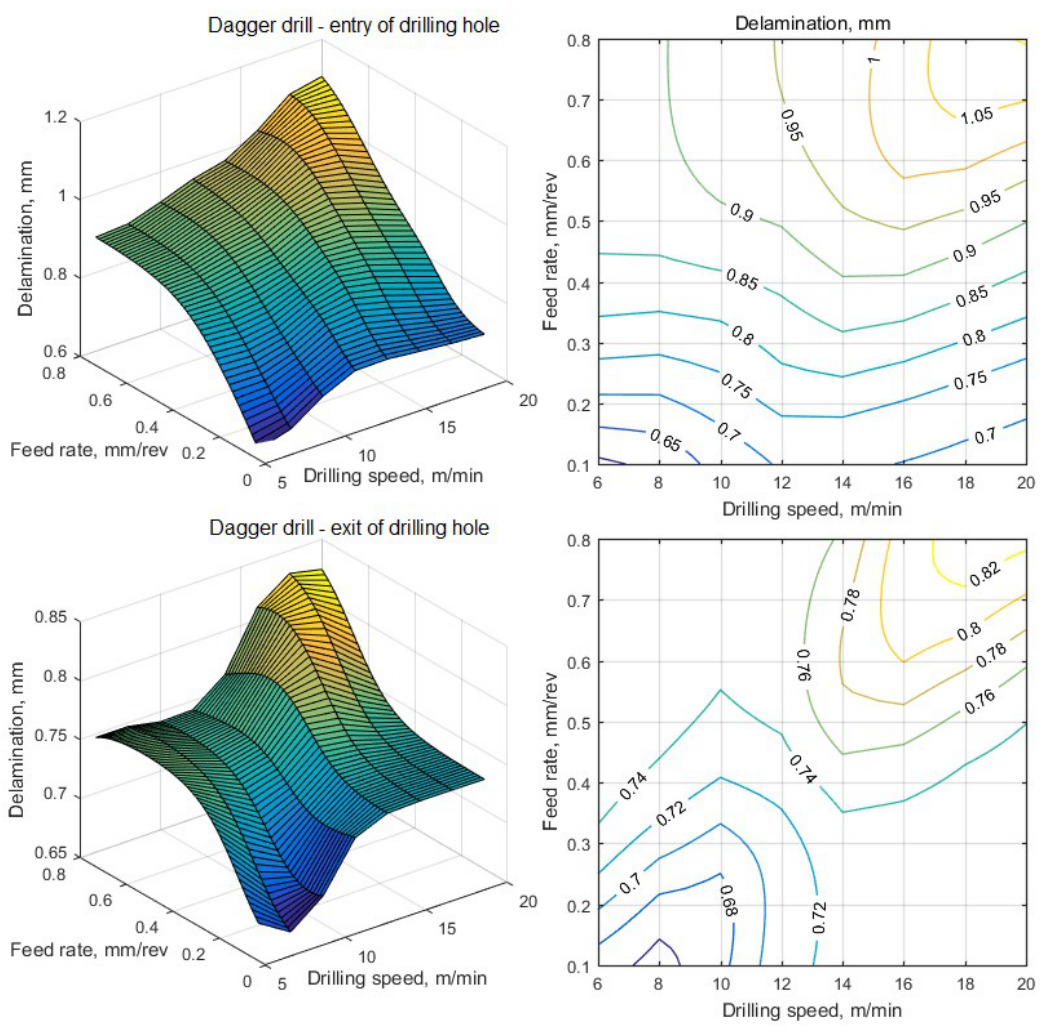
Figure 8. ANN-fitted delamination response functions at the entry ( top ) and exit ( bottom ) of a hole drilled with dagger drill is presented as 3D surfaces ( left ) and contour plots ( right ).